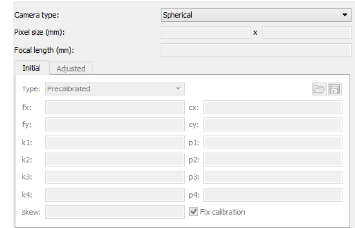
Figure 10. “Camera Calibration” window. Agisoft PhotoScan.